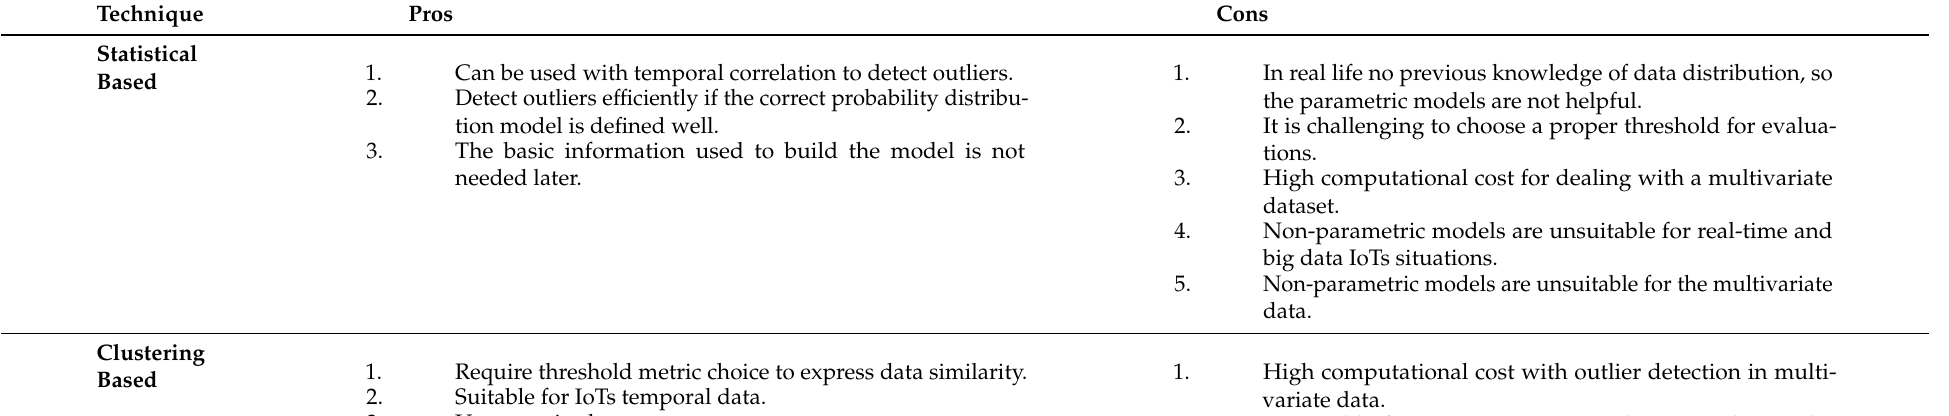
Table 9. Comparative Table of Pros and Cons of Outlier Detection Techniques.